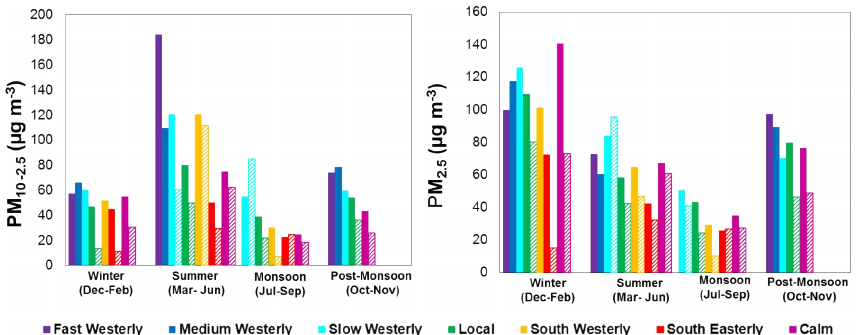
Figure 6. Mean coarse-mode (PM 10–2 . 5 ) and fine-mode (PM 2 . 5 ) mass loading for each air-mass cluster and season at the IISER Mohali air quality station. Hatched bars indicate coarse-mode and fine-mode PM mass loadings observed during rain events.